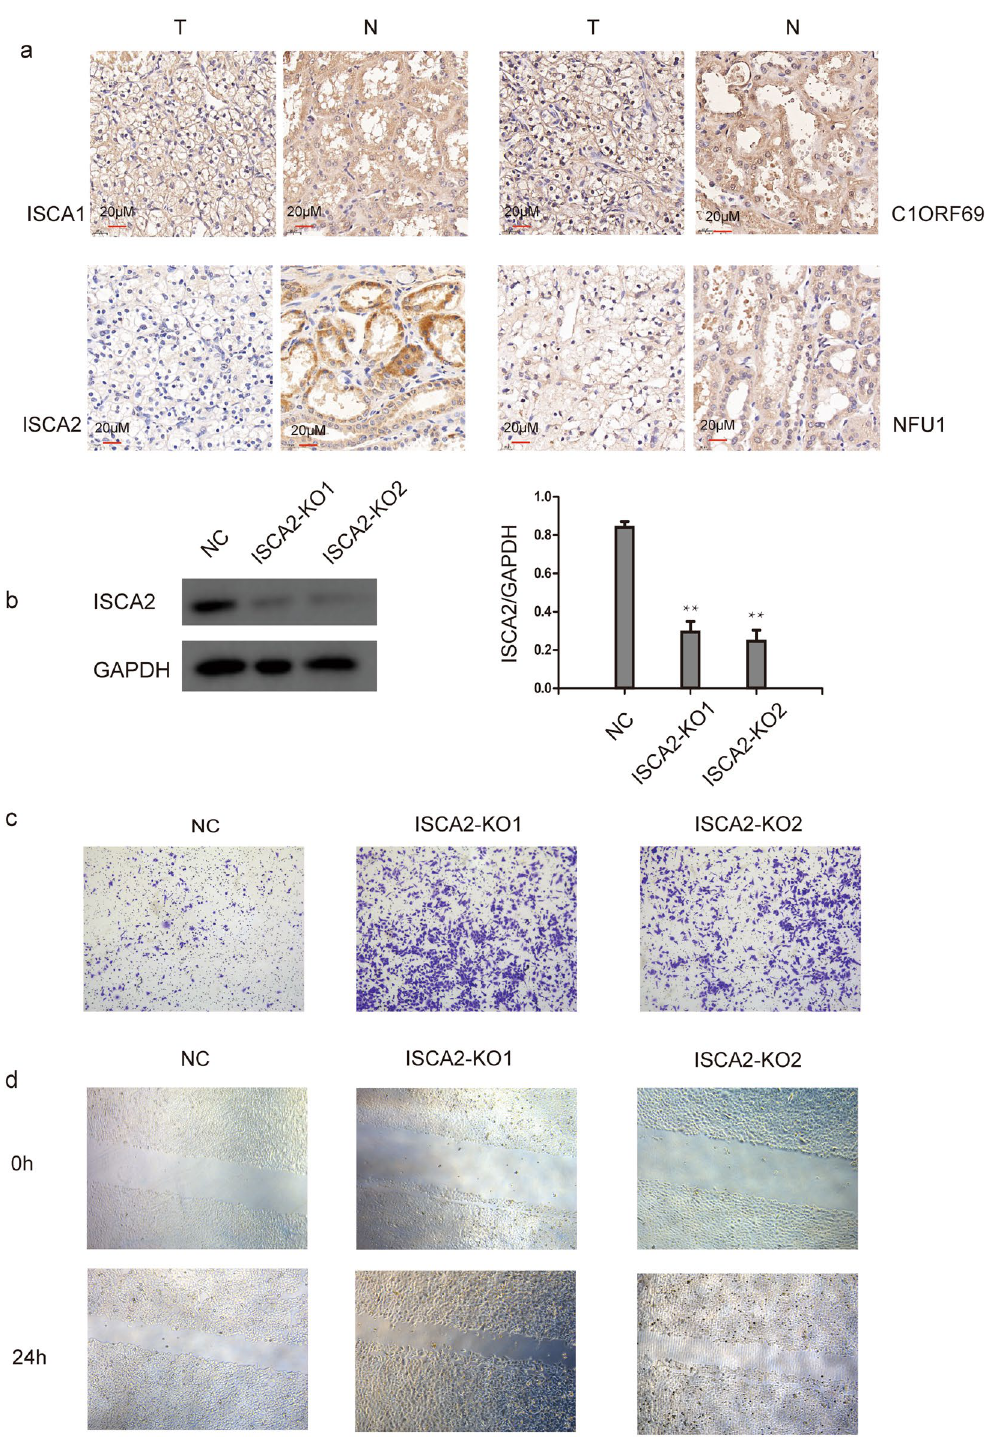
Figure 6. The expression of the MMDS related iron–sulfur protein genes in KIRC (IHC). ( a ) The expression of the MMDS related iron–sulfur protein genes in KIRC, N (normal kidney tissue), T (kidney tumor tissue); ( b ) WB experiment is used to verify the knockout effect (the blots cut prior to hybridization with antibodies). ( c ) The migratory ability of ISCA2 deficiency in RCC-7860 cells was assayed using an uncoated transwell assay. ( d ) Cell migration of RCC-7860 cells after ISCA2 deficiency was measured by wound healing assay (24